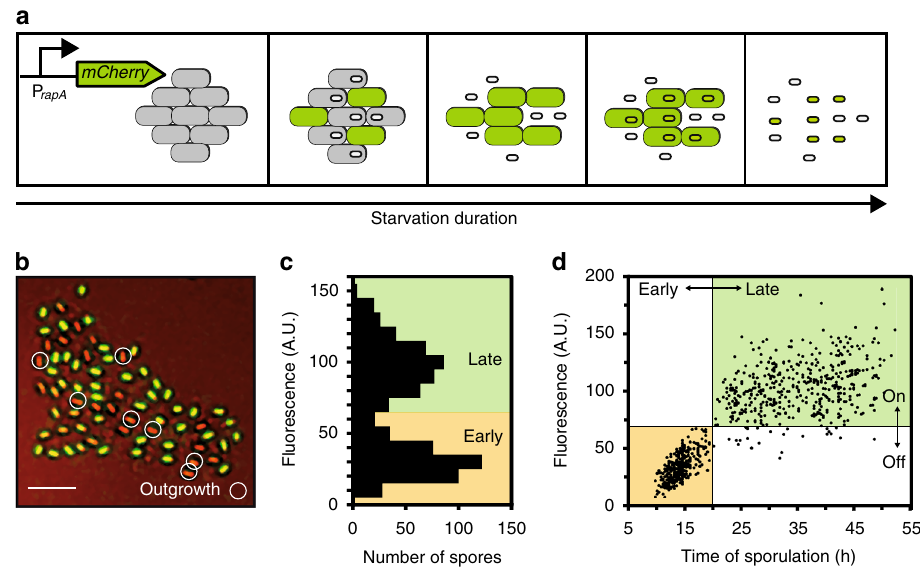
Fig. 5 A fl uorescent marker distinguishes early from late spores. a Illustration of the function of the P rapA - mCherry reporter. b Image of a microcolony of spores carrying the P rapA - mCherry reporter system (BIB1126). The bright- fi eld image (red) was overlaid with the fl uorescence image (green). Two subpopulations of spores can be distinguished. The circled spores grew out in response to L -alanine. Scale bar, 5 µ m. c Histogram of fl uorescence intensities of spores ( n s = 810). d Corresponding fl uorescence intensities of individual spores plotted as a function of their sporulation time ( n s = 810). Yellow/green areas denote the classi fi cation of spores based on sporulation timing